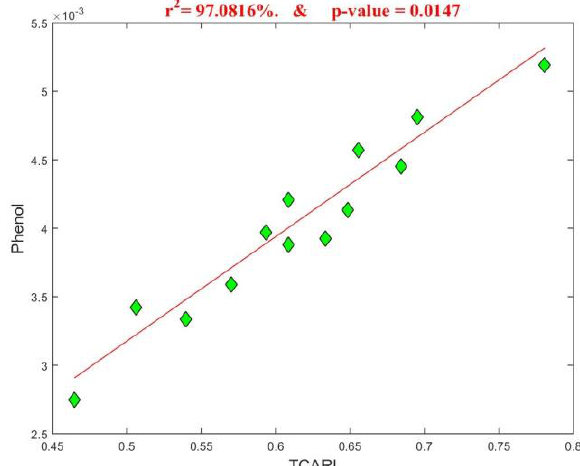
Figure 3. The highest correlation rate for 2013 was established with the TCARI for estimation of the Total Phenolic Content